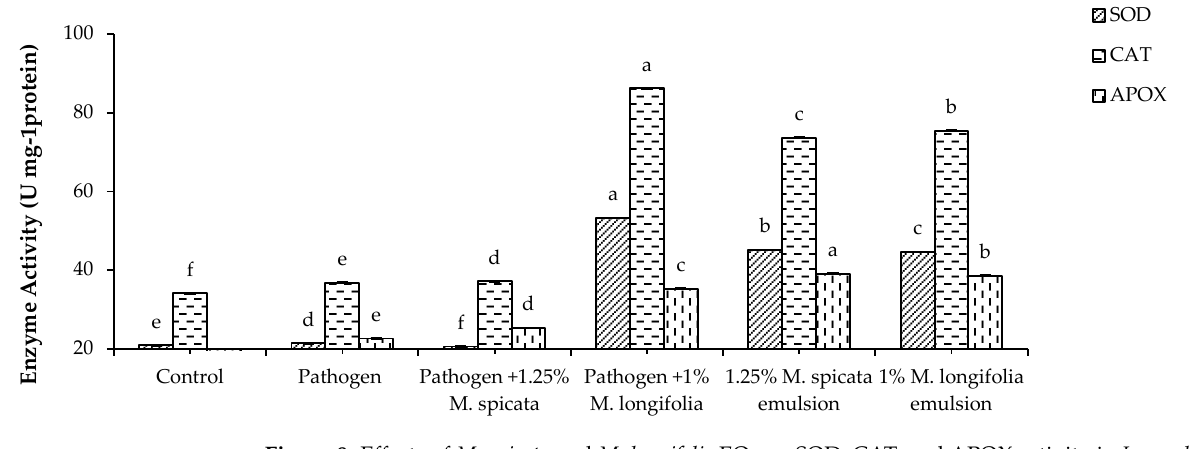
Figure 8. Effects of M. spicata and M. longifolia EOs on SOD, CAT, and APOX activity in L. esculentum seedling under Fusarium root rot disease infection. Bars with different letters indicate significant differences between treatments at p ≤ 0.05. Data are expressed as the mean of three replicates ± SDs.